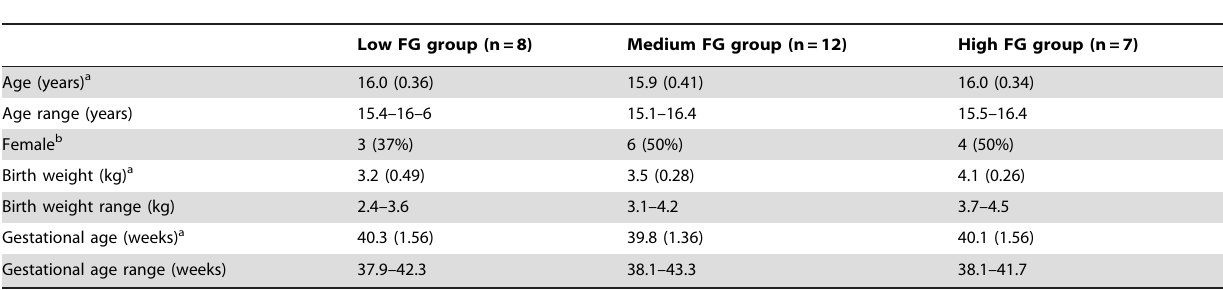
Table 1. Characteristics of the sample as represented by three groups of fetal